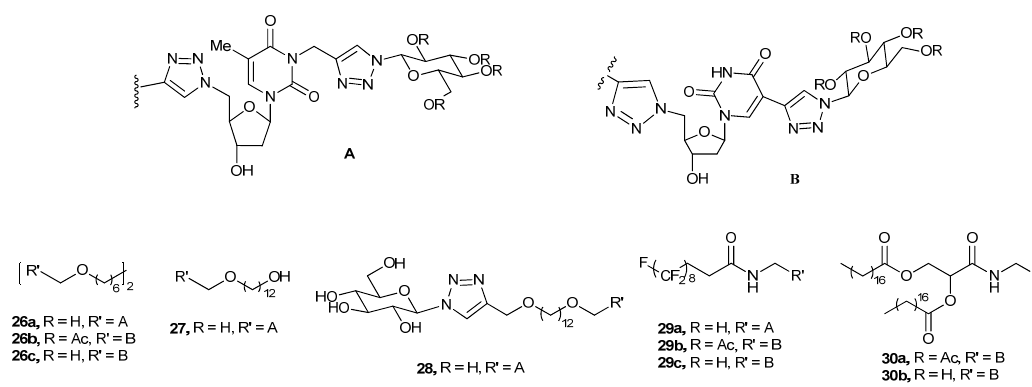
Figure 17. Phenyl centered glycosylated triazoles. Gels 2018 , 4 , x FOR PEER REVIEW